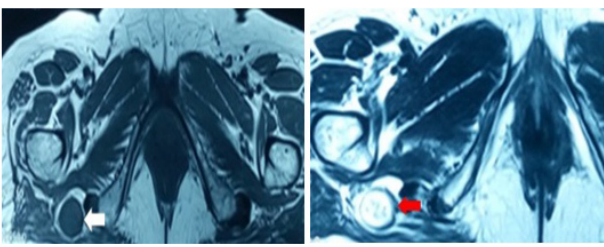
Figure 1. MRI scan showing an oval, well circumscribed and homogenous lesion lying near the ischial tuberosity.